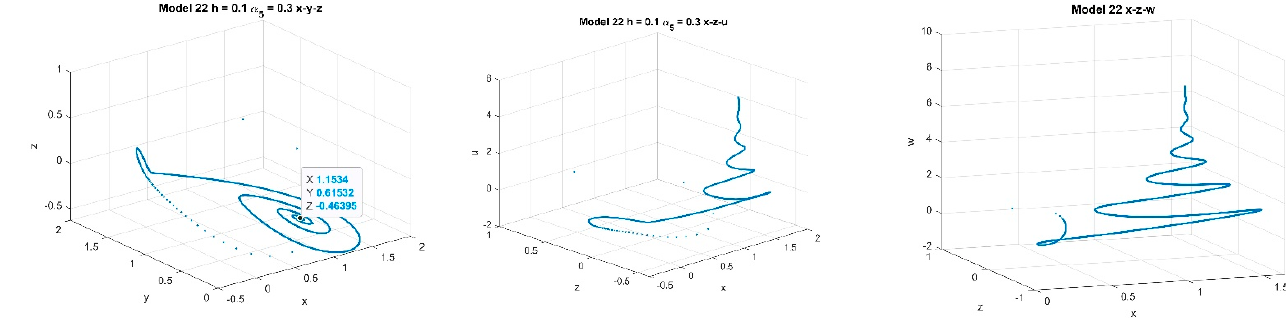
Figure 8. ESDDFD model (25); ( a ) u vs. α 5 , ( b ) x vs. α 5 , ( c ) z vs. α 5 , at k = 2, p = 1, α 5 ∈ [ 0.232, 0.328 ] . For step sizes above 0.003, CEFD, (21), fails. MCEFD, (22) fails for step sizes above 0.573. The graphs in Figure 9 were produced using the same parameter values as before, except ℎ = 0.1 . The graphs in Figure 10 were done with h = 1.0. These show the effect of larger step sizes on methods (23), (24), and (25). The ESDDFD methods preserve the end early behavior between the methods, especially when compared with h = 0.002.